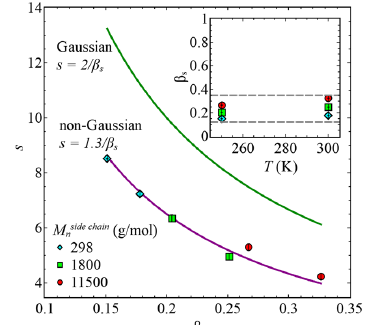
Fig. 10. Power law, 𝑠 , as a function of stretching parameter, 𝛽 (cid:3046) , for all three sample and both temperatures, 𝑇 (cid:3404) 250 K, and 𝑇 (cid:3404) 300 K. Sold green lines corresponds to Gaussian behaviour for a homogenous system. Solid purple line corresponds to 𝑠 (cid:3404) 1.3/ 𝛽 (cid:3046) . Data has